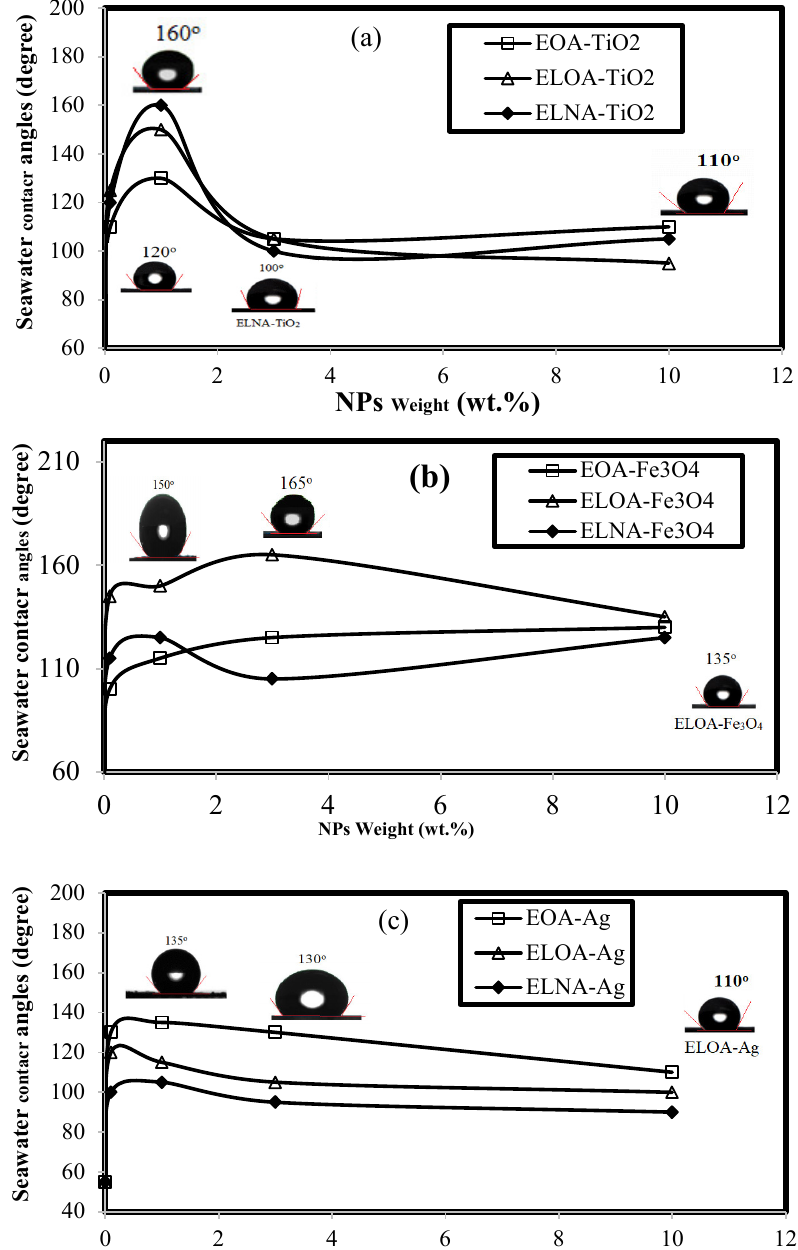
Figure 14. Seawater contact angle (WCA) measurements on the cured DGEB/PA nanocomposites with modified ( a ) TiO 2 , ( b ) Fe 3 O 4 and ( c ) Ag NPs wt %.